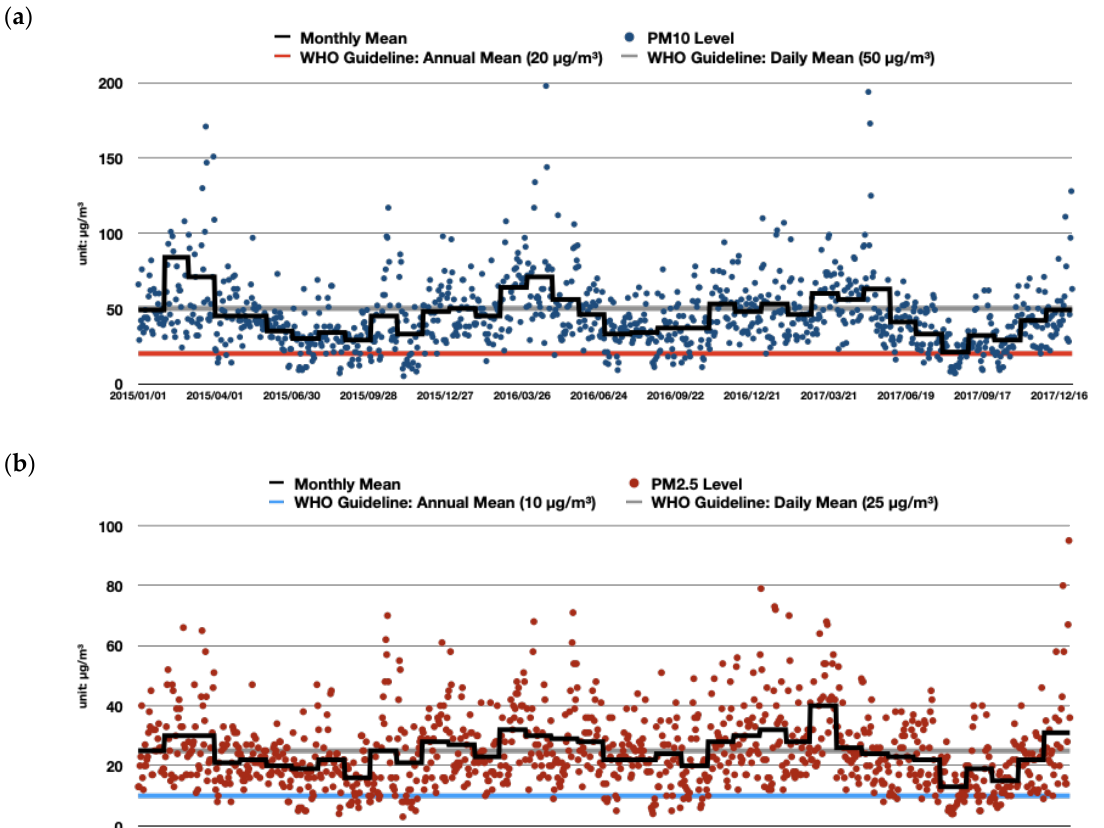
Figure 1. ( a ) Daily mean levels of particulate matter of 10 micrometers or less in diameter (PM 10 ) in Seoul from 2015 to 2017 compared with the World Health Organization’s (WHO’s) guidelines on annual and daily means; ( b ) daily mean levels of PM of 2.5 micrometers or less in diameter (PM 2.5 ) in Seoul from 2015 to 2017, compared with the WHO’s guidelines on annual and daily means. Data source: Seoul Atmospheric Environment Information (http://cleanair.seoul.go.kr/).